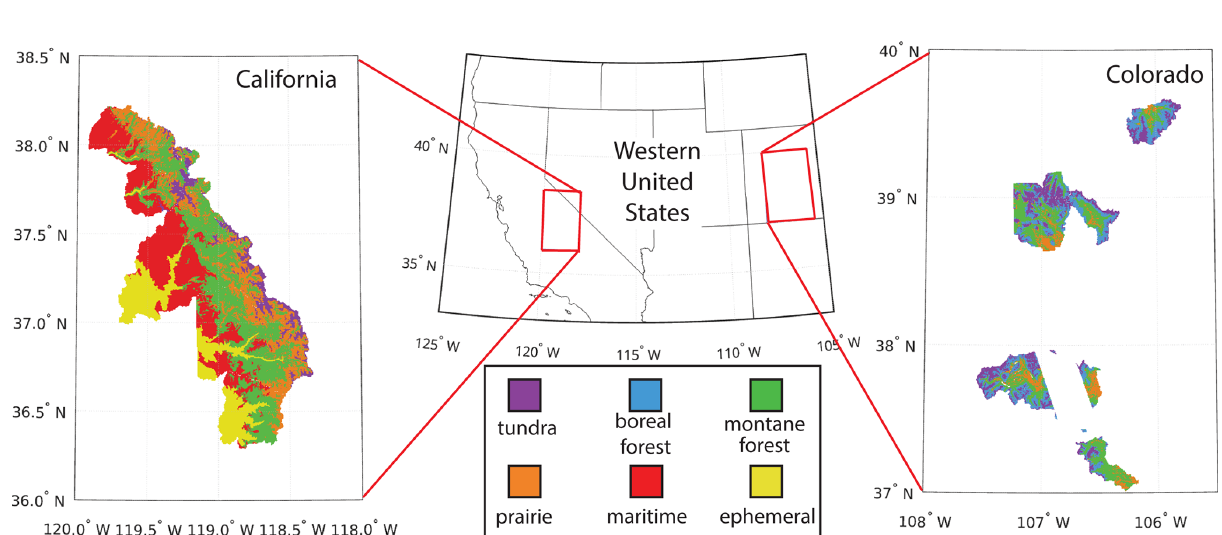
Figure 3. Snow cover types present in the ASO validation flight locations. All six of the Sturm and Liston (2021) seasonal snow type classes are present in the combined California and Colorado ASO